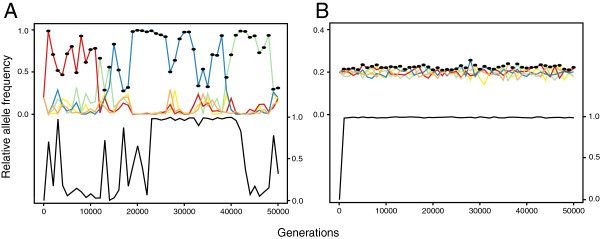
Two illustrative runs of the individual-based simulation, showing allele frequencies at the recognition locus (coloured lines) and behaviour locus (black line). Black dots mark the recognition allele with the highest frequency among individuals with at least one cooperative allele. Panel A: In this run, cooperation eliminated recognition locus diversity. The figure assumes the following parameter space: x = 6, b = 6, c = 1, m = 0, N = 6, k = 5, r = 0.05, d = 0.1, μ = 10-5, h = 1 and 2-allele matching, as in the centre of Figure 2B. Panel B: The cooperative allele invaded without depleting recognition locus diversity. The parameter space is the same as before except b = 3 and m = -1, as in the bottom left of Figure 2B.